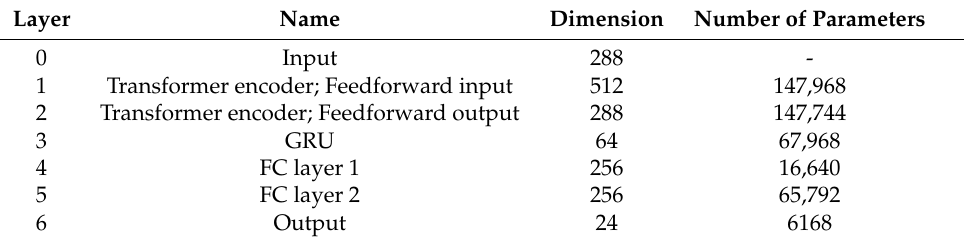
Table 2. Structure of the proposed